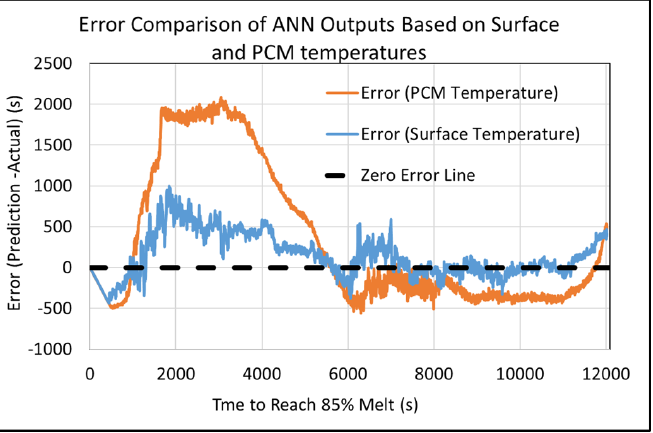
Figure 21. Comparison of error in predictions from the ANN model trained using transient surface- temperature data and transient PCM-temperature data (for test data set of 2.3 V and training data set of 2.8 V).